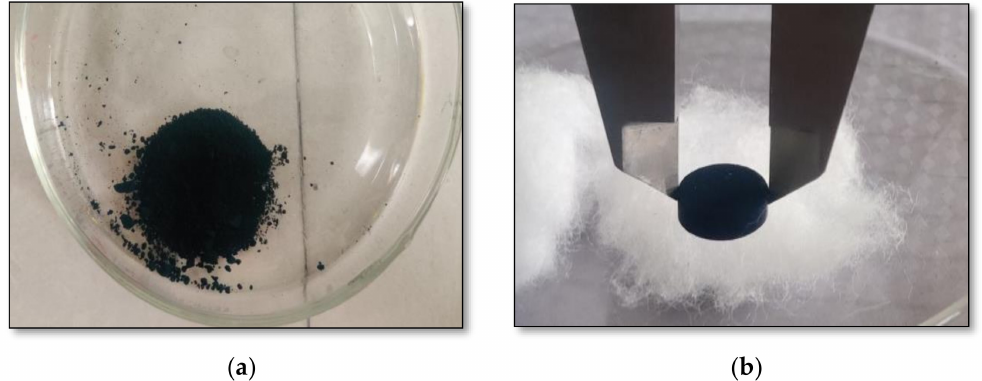
Figure 15. ( a ) Polyaniline (ES) obtained after synthesis. ( b ) Pallet of PANI